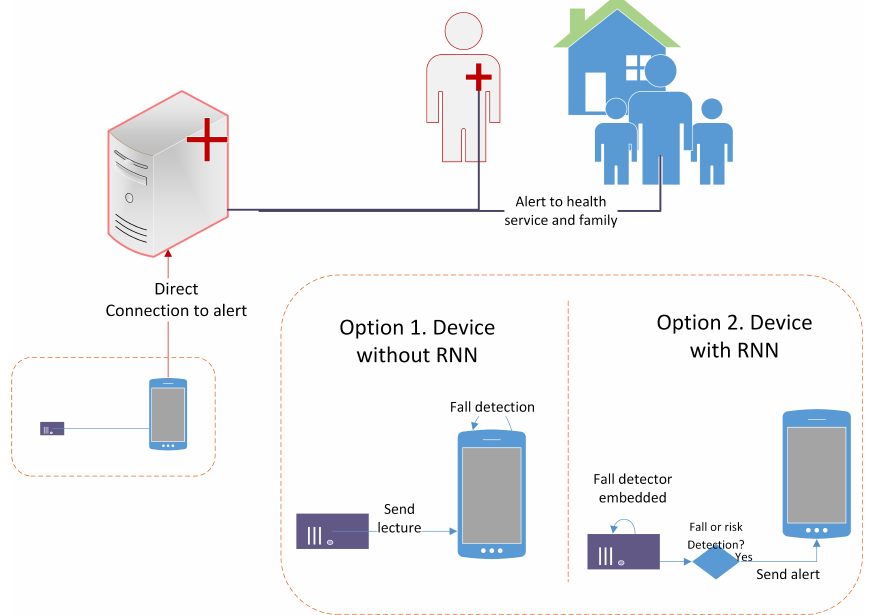
Figure 3. Fall detector system versions. In option 1, the microcontroller sends the accelerometer readings, and a master device executes the RNN algorithm. In option 2, the RNN model is implemented in the microcontroller, and only sends a notification when a fall or a fall hazard event